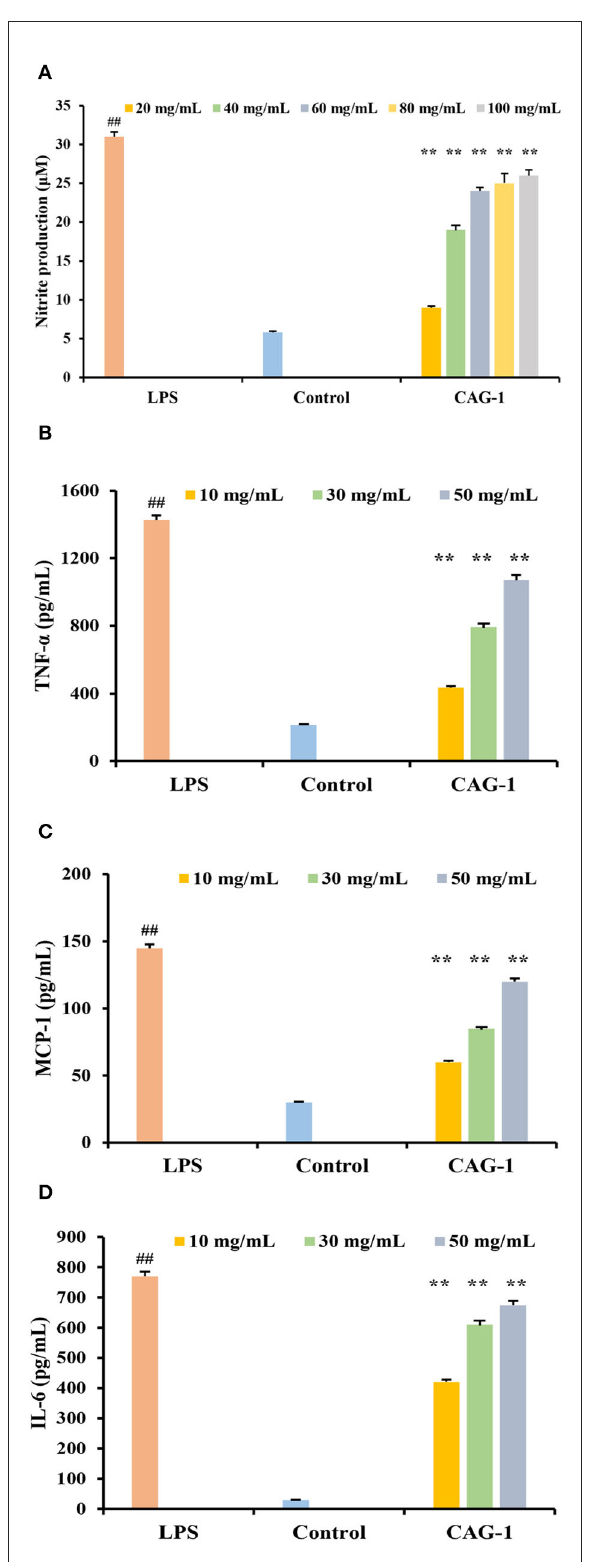
FIGURE6 Effects of CAG-1 on the production of nitric oxide (NO), tumor necrosis factor- α (TNF- α ), monocyte chemotactic protein